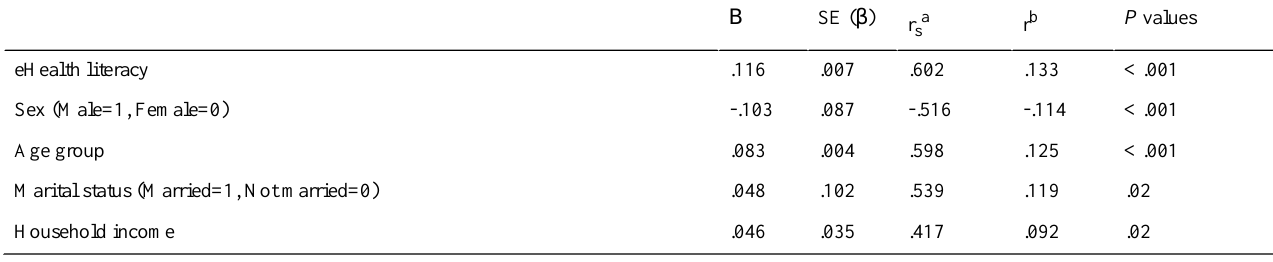
Table 4. Multiple regression for Knowledge score of CRC by eHealth literacy and sociodemographic factors.